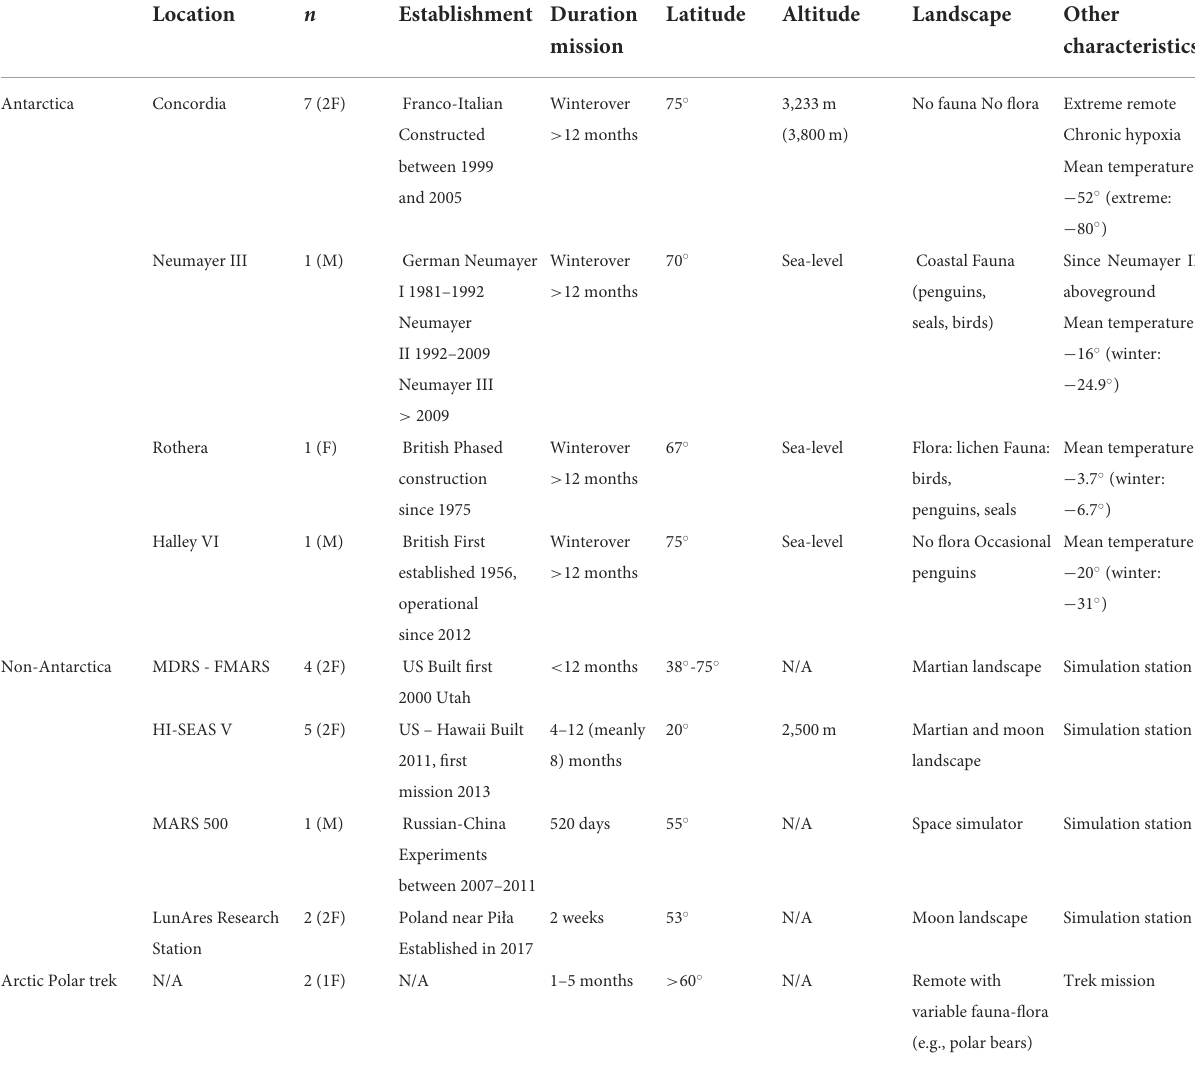
TABLE 1 Overview of the (Antarctic) (simulation) stations and their most important characteristics as well as the number of interviewees that sojourned there.